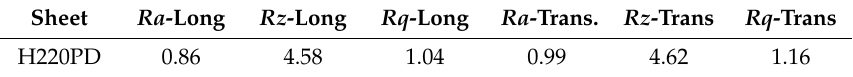
Table 8. Sheets-surface parameters acc. to ISO 4287, Profilomer SJ-201 ( μ m) . Sheet